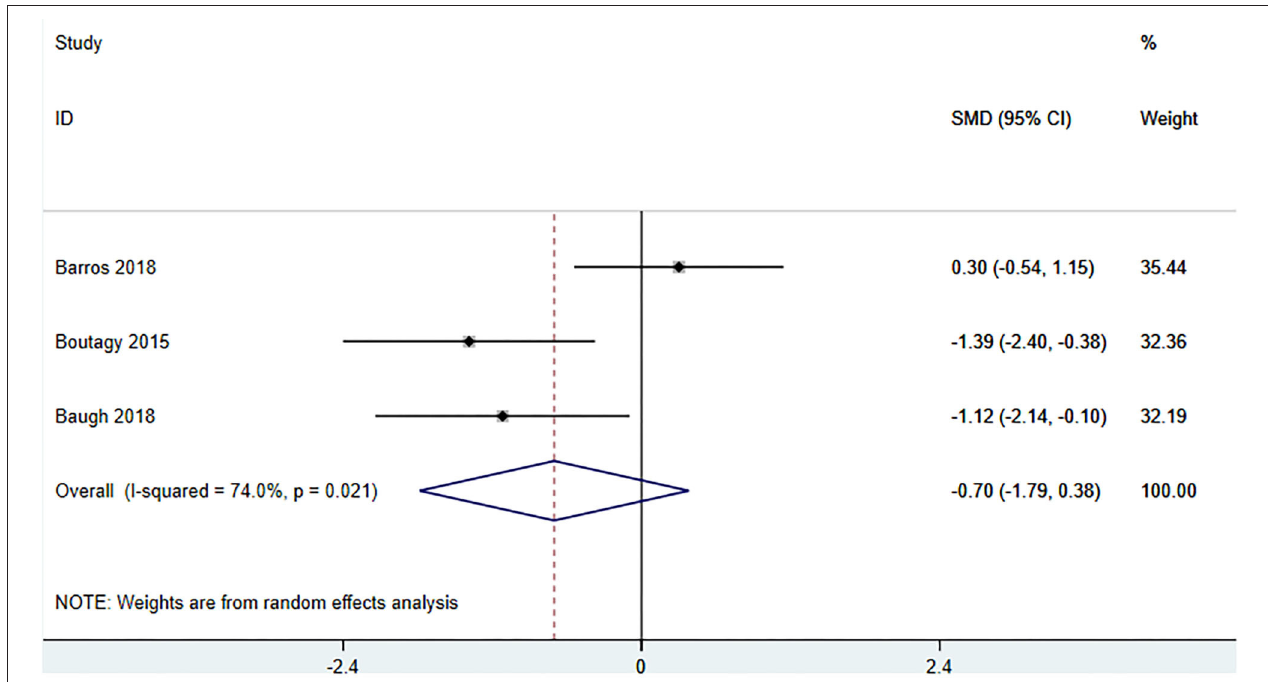
FIGURE 9 | Forest plot for the effect of microbiota-driven therapy on circulating betaine aldehyde level. The effect size of each trial or the overall was represented as black diamond and the weight of each trail in the overall study was represented as gray box around black diamond. The estimated 95% confidence interval of effect size was identified by extending lines. CI, confidence interval; RCT, randomized controlled trial; SMD, Standard Mean